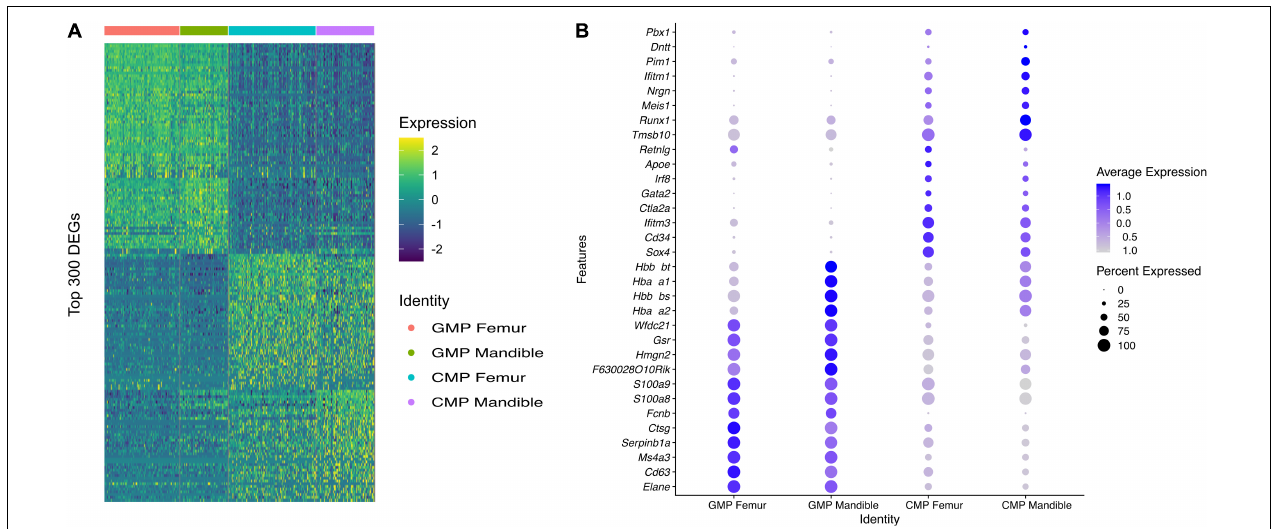
FIGURE 6 | CMP and GMP populations show transcriptomic differences in fBM and mBM. (A) Heatmap of the topmost differentially expressed genes in both CMP and GMP populations, as well as between fBM and mBM. (B) DotPlot showing the top genes that are differentially expressed between the femur and the mandible in both CMP and GMP populations.